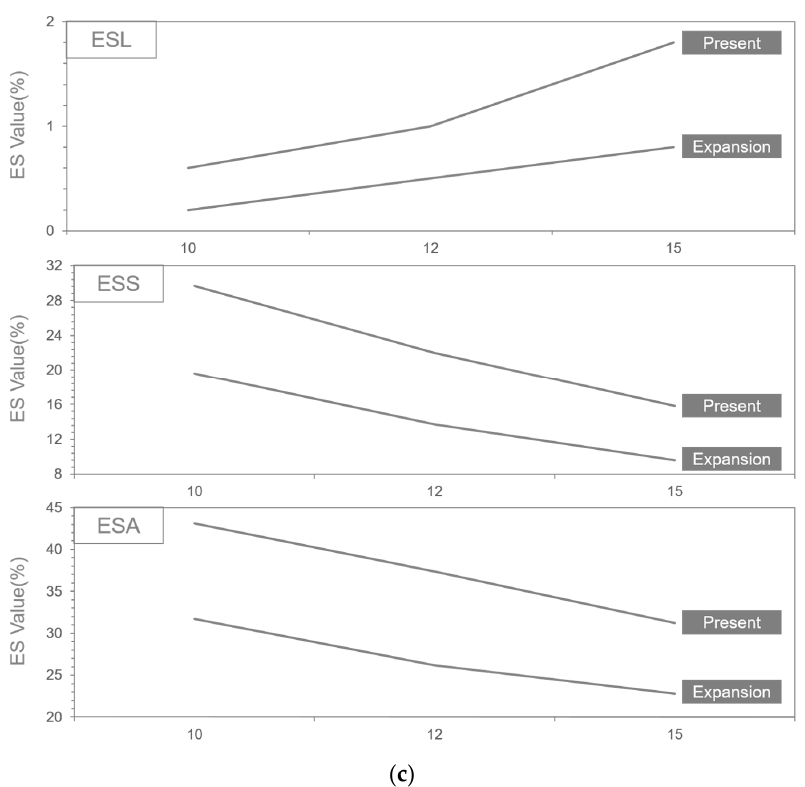
Figure 11. ( a ) Analysis of the ES value before and after expansion of the Yeosu fairway, ( b ) the Masan fairway, and ( c ) the Gadeok fairway.